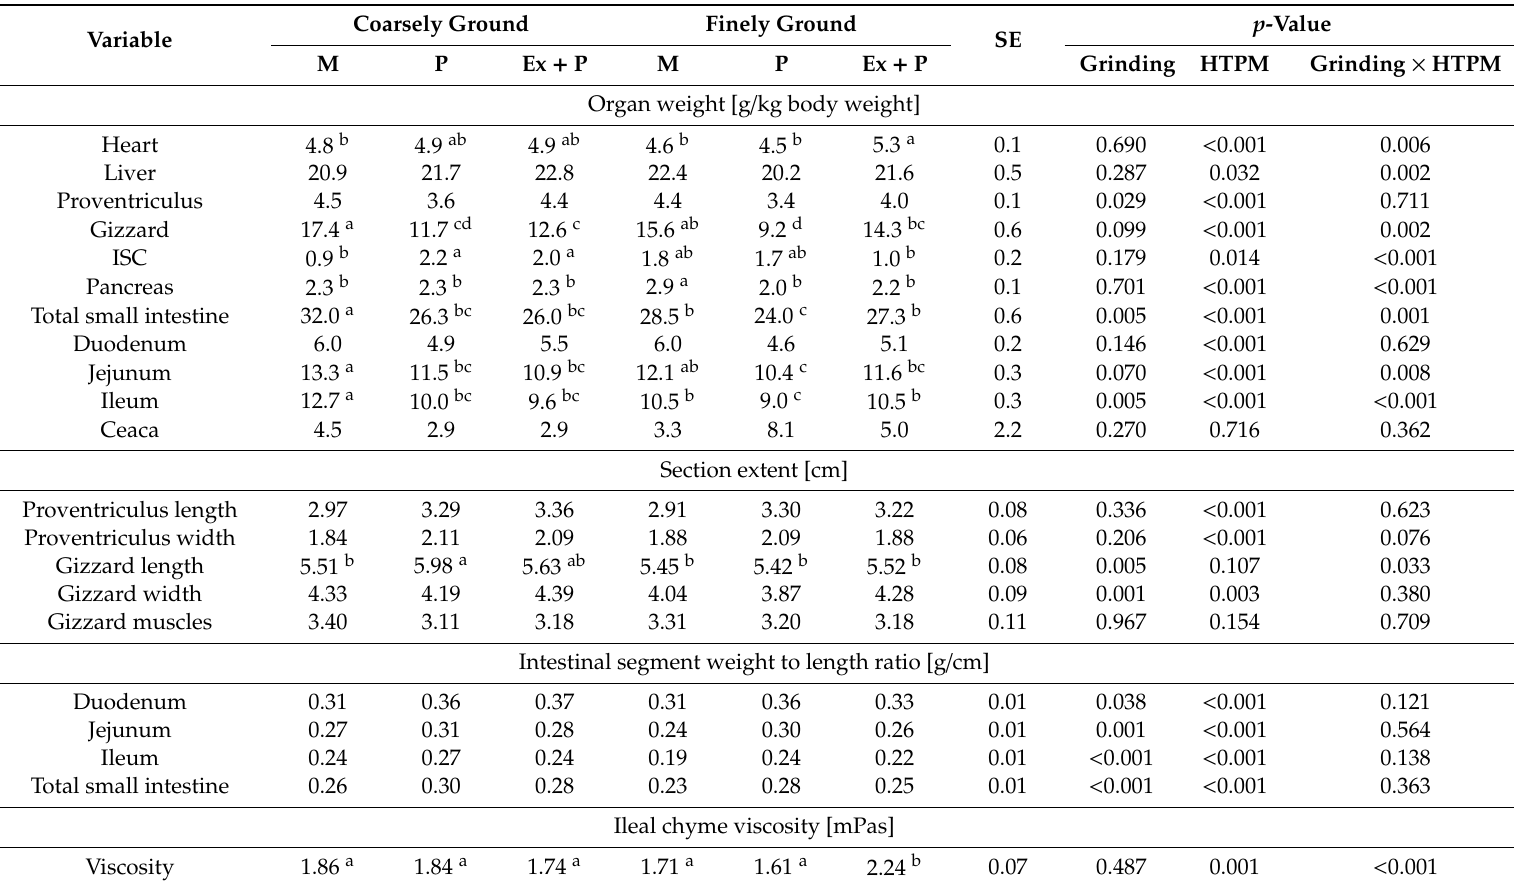
Table 7. Organ traits (LSMeans; n = 16), 35 day old